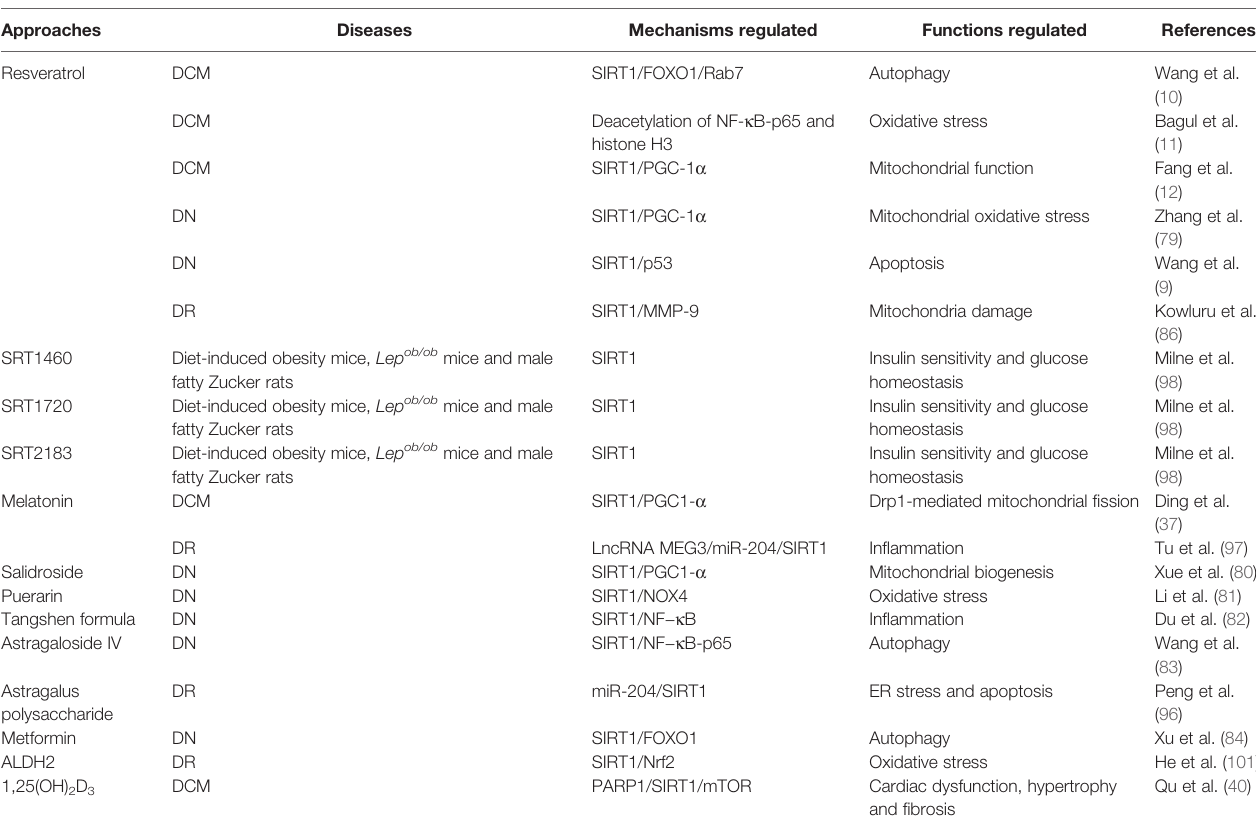
TABLE 2 | SIRT1 agonists and their respective roles in diabetic complications.